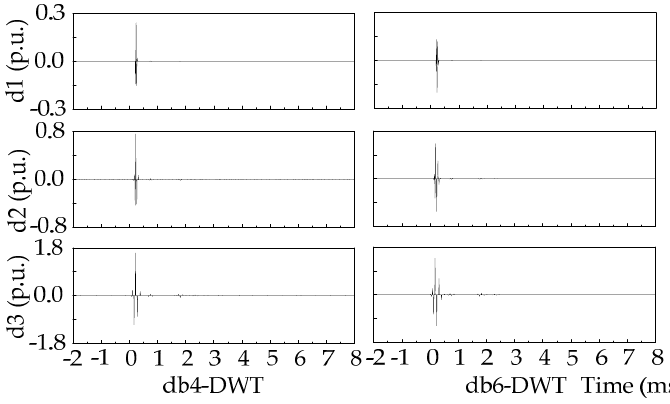
Figure 13. The discrete wavelet transform (DWT) results of the sixth mode currents at the rectifier-terminal during PG faults 50 km from the rectifier-terminal with a fault resistance of 100 Ω .